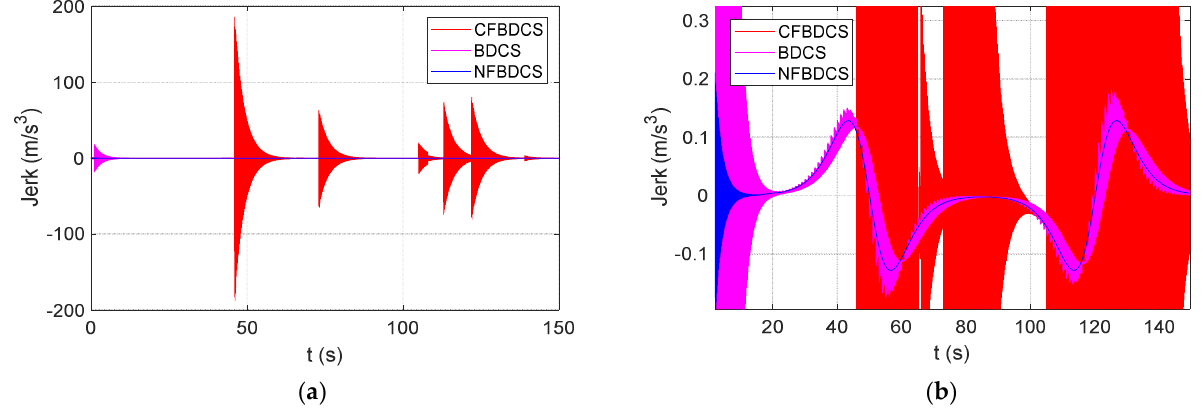
Figure 20. ( a ) Jerk of vehicle with Δ t = 1 s, ( b ) Jerk of vehicle with Δ t = 1 s (amplified).